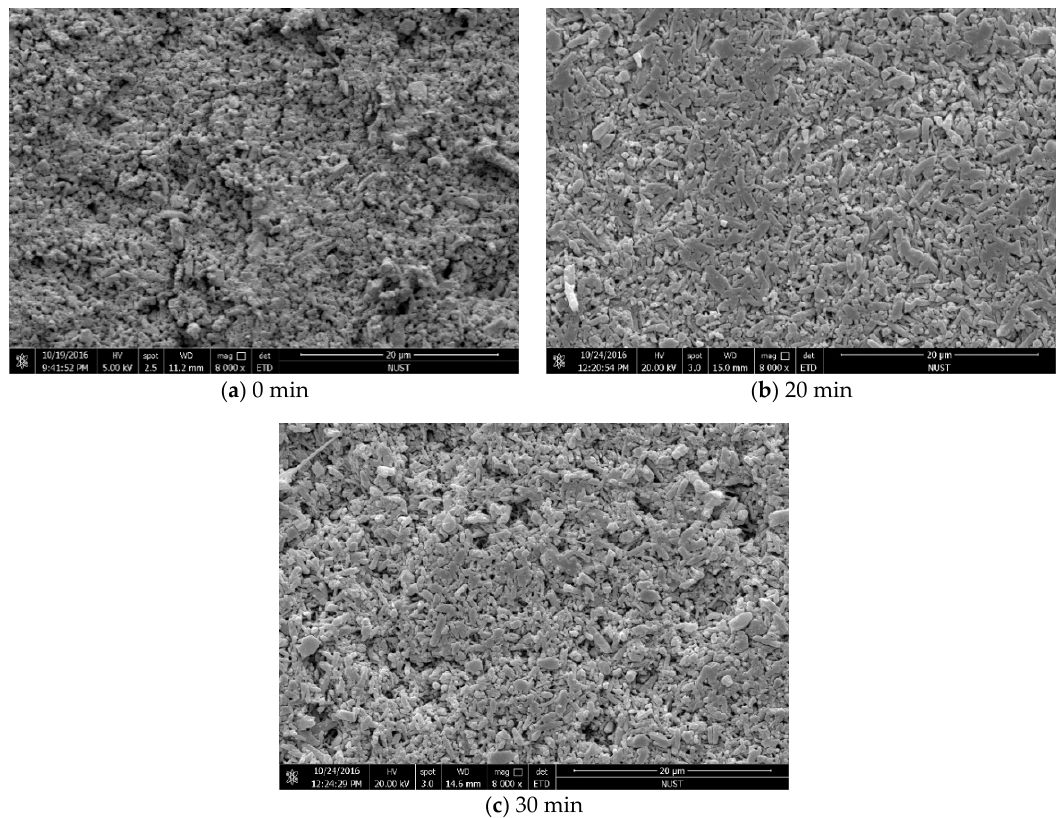
Figure 10. SEM micrographs of the fracture surface morphology of the samples after molten NaOH corrosion at different holding time (sintering temperature for 1600 °C).